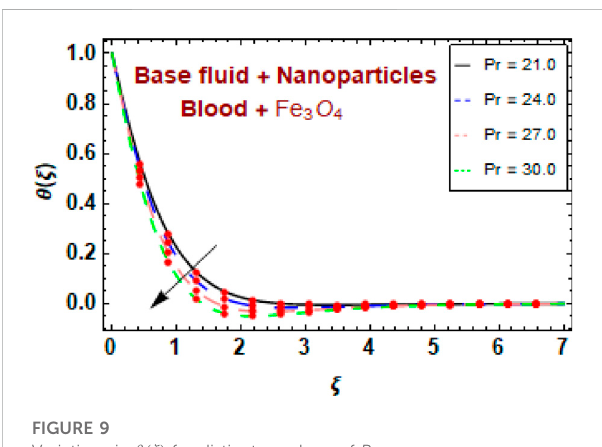
FIGURE 9 Variations in θ ( ξ ) for distinct numbers of Pr